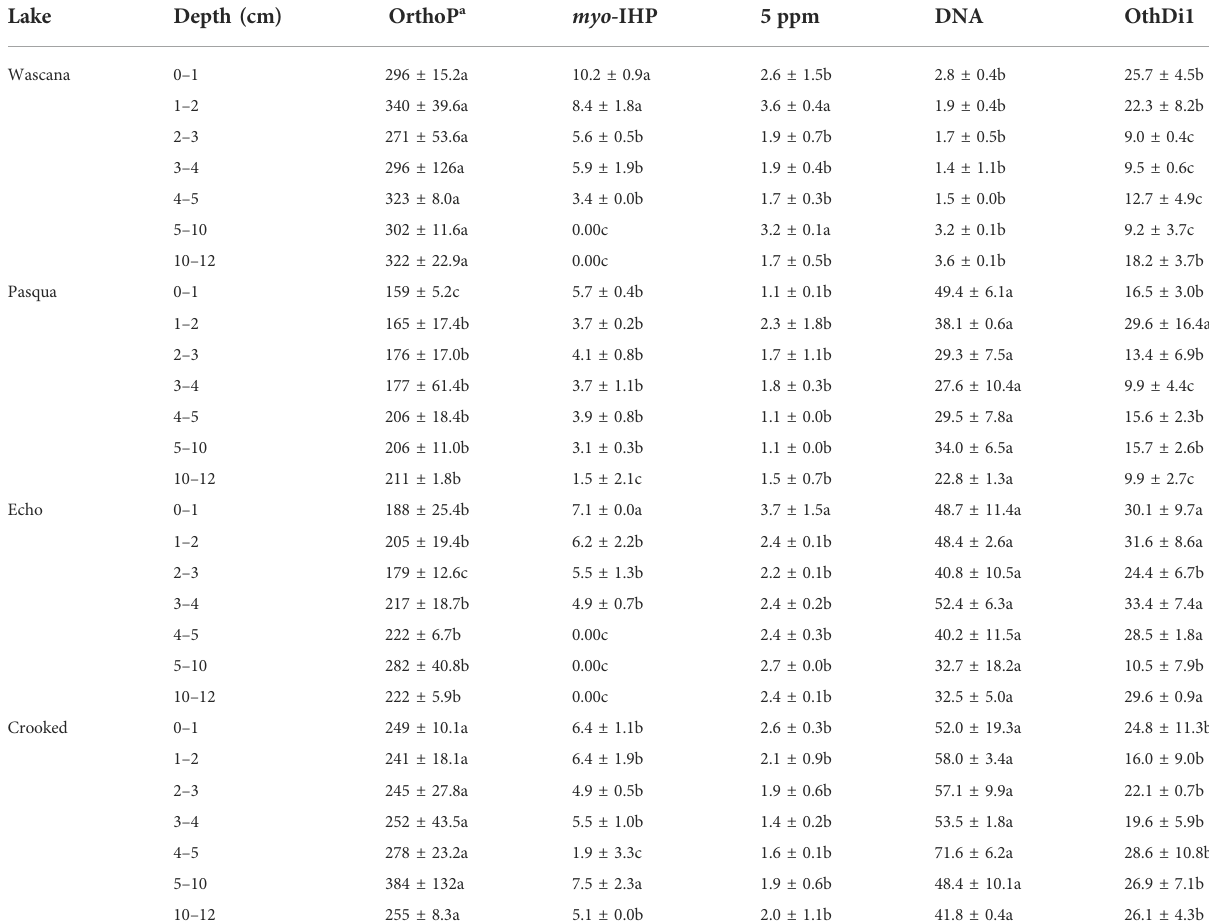
TABLE 2 Concentrations (mg P kg − 1 dry weight) of orthophosphate and organic P compounds in NaOH-EDTA extracts of sediments analyzed by P-NMR spectroscopy. Values are means (±SD); n = 2 (duplicate cores) per depth. Different letters indicate signi fi cant ( p < 0.05) differences in concentrations among depths and lakes for each P species, determined by two-way ANOVAs followed by Tukey HSD post-hoc tests using centred- log ratio data. Lake Depth (cm) OrthoP a myo -IHP DNA OthDi1